Question: Condense the content of this figure into a single sentence.
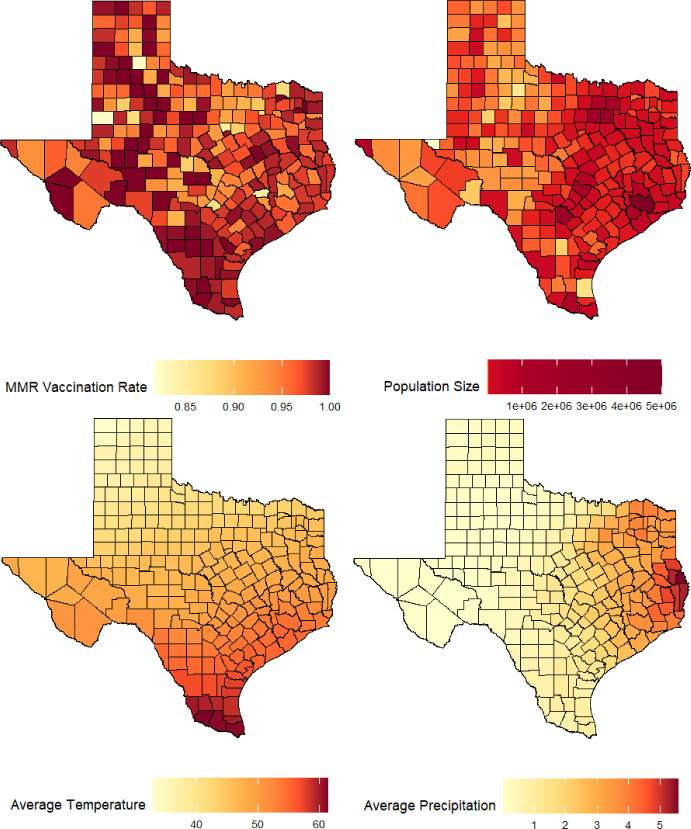
Answer: Spatial distribution of demographic, epidemiological, and climate variables